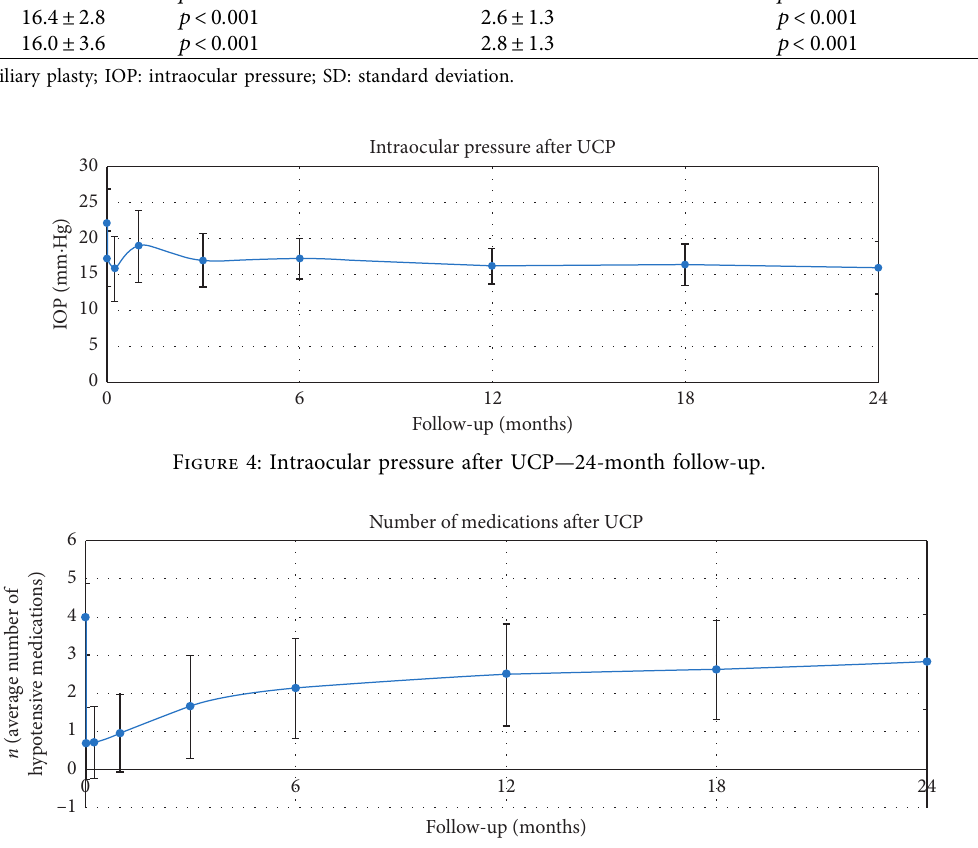
Figure 5: The number of antiglaucoma medications after UCP—24-month follow-up. Table 4: Correlation between scleral and conjunctival thickness in superior/inferior scleral mark and IOP after UCP. SCT